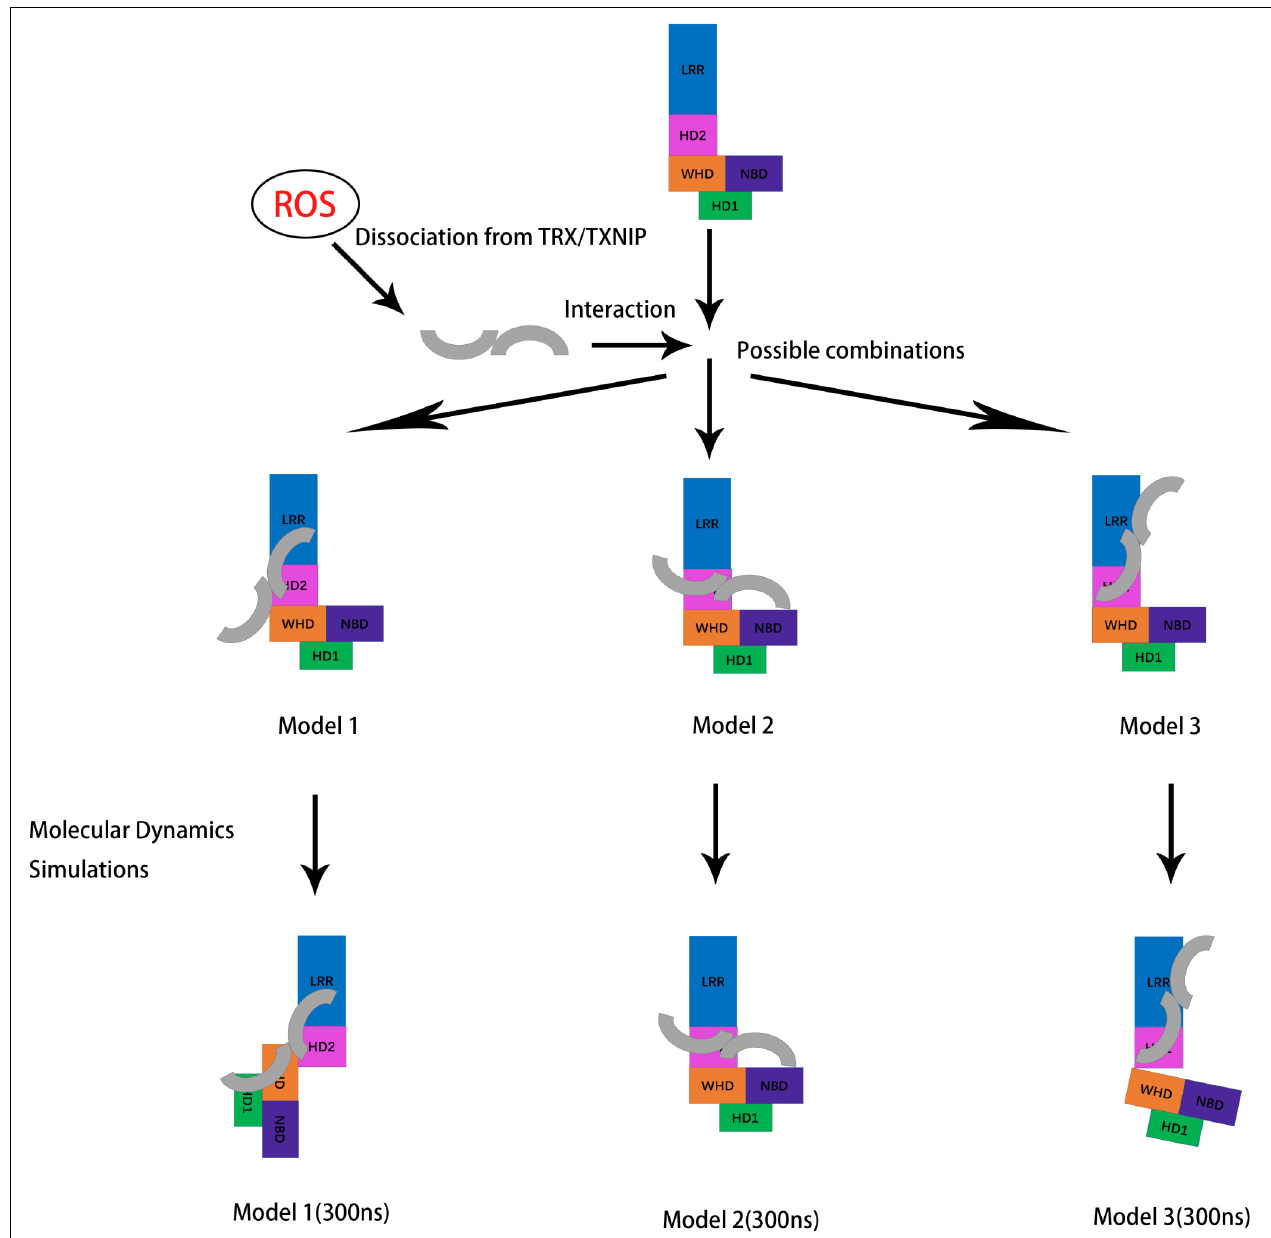
FIGURE 9 | Schematic diagram showing the potential conformations of the three constructed models for NLRP3/TXNIP binding after molecular dynamics simulations. TXNIP dissociated from TRX under ROS stimulation. Then, TXNIP and NLRP3 were bound at the potential interface. Molecular dynamics simulations of the models were performed, and the outputs of the last frame of model trajectory were the final